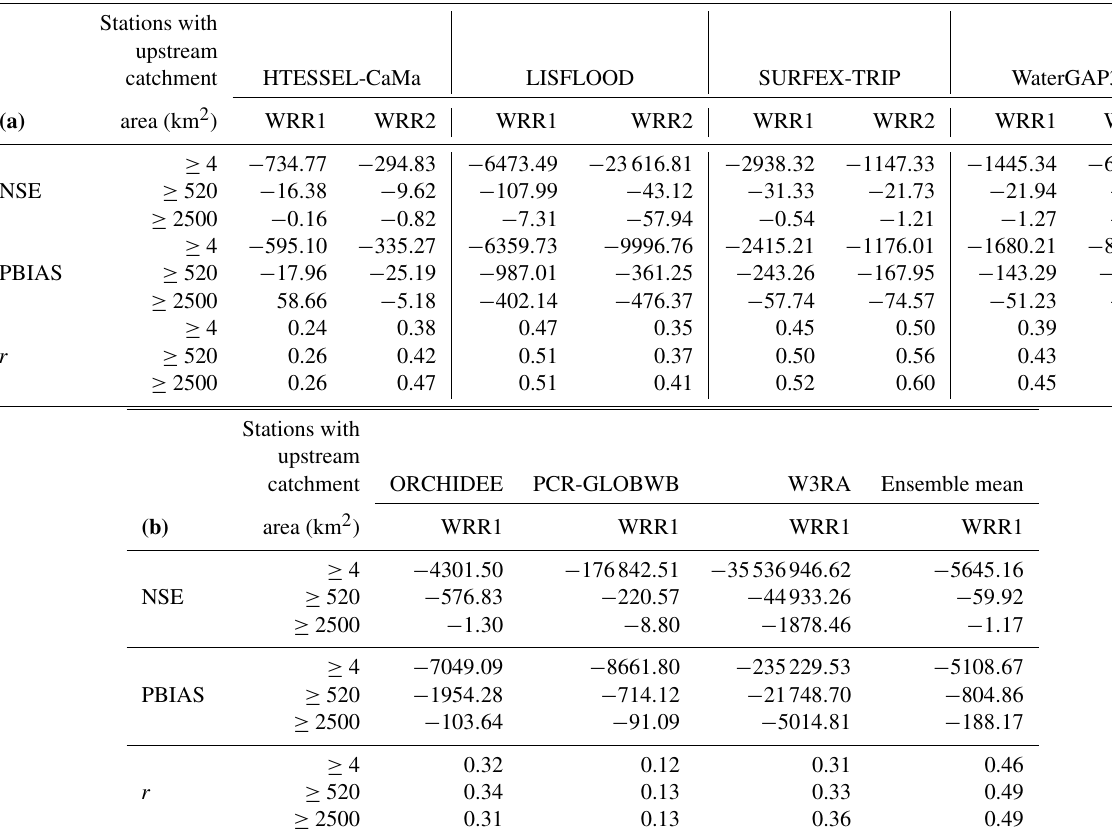
Table 4. Performance statistics for the four models available in WRR1 and WRR2 (Table 4a) for each of the 75 gauging stations in the Limpopo River basin, and the three models and ensemble mean only available in WRR1 (Table 4b). Statistics displayed for WRR1 and WRR2 include the Nash–Sutcliffe efficiency (NSE), the percent bias (PBIAS) and Pearson’s r ( r ). The three different upstream catchment areas indicate that an average is taken of the error statistics of the stations that are larger than indicated. Stations ≥ 4km 2 indicate all 75 stations, ≥ 520km 2 are the largest 31 stations and ≥ 2500km 2 are the largest 11